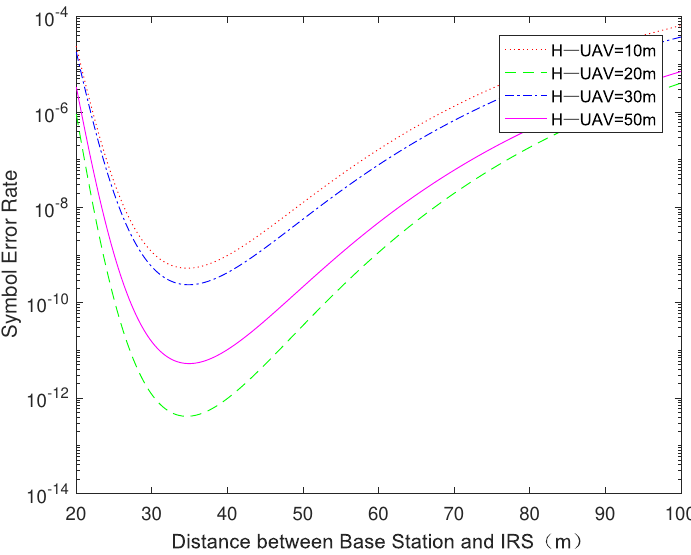
Figure 3. Symbol error rate versus d 1; K =